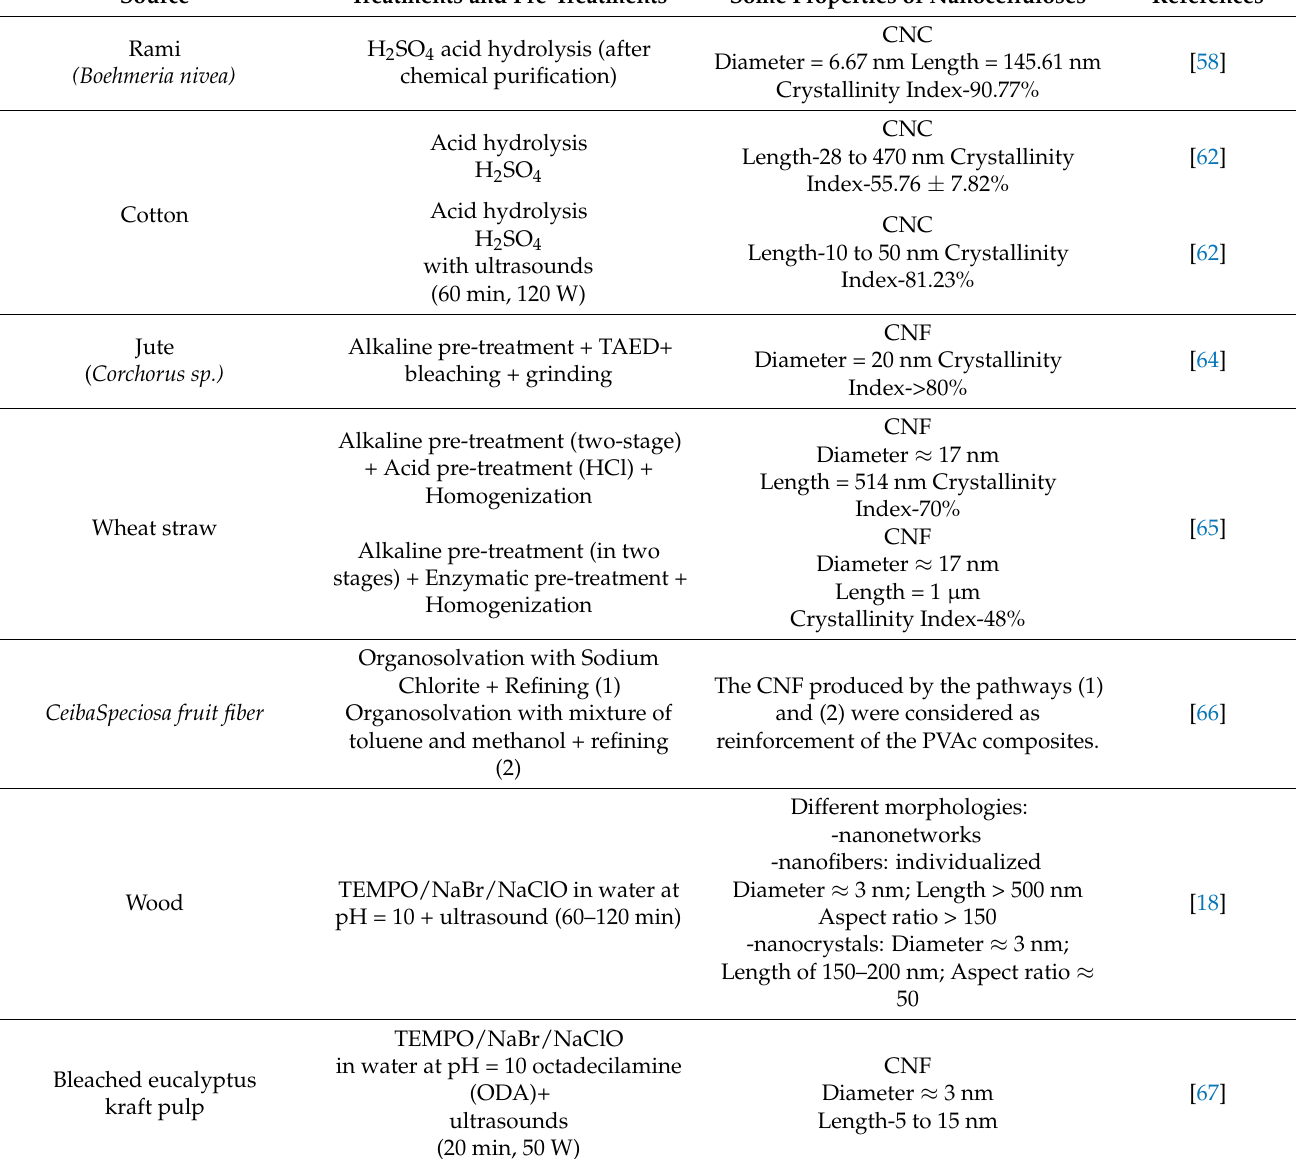
Table 4. Pre-treatments and/or chemical treatments